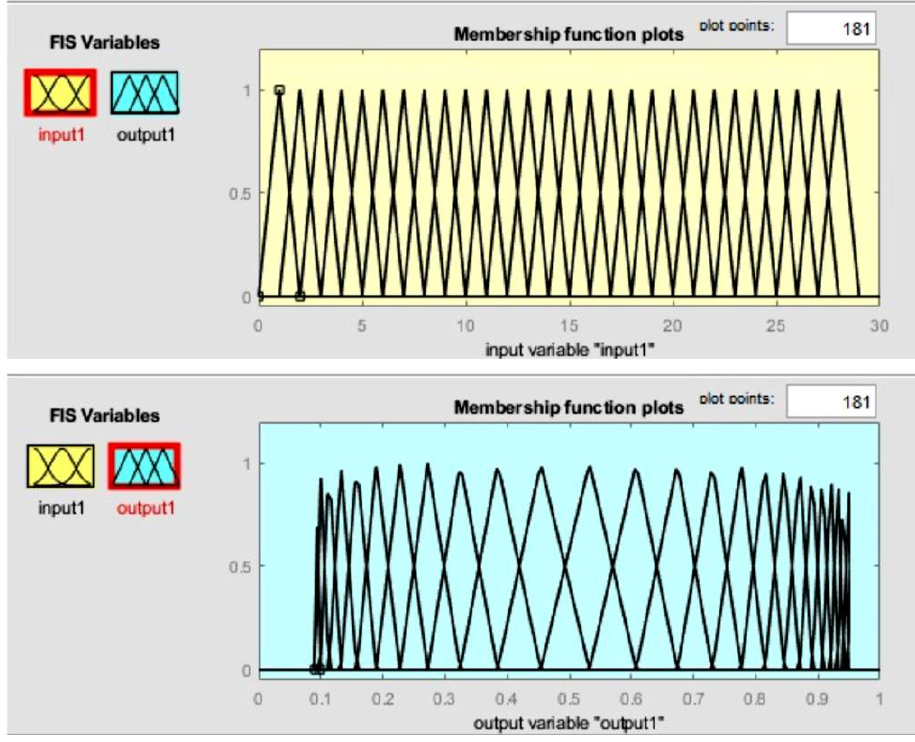
Figure 9. MFs for MAP input and throttle output.